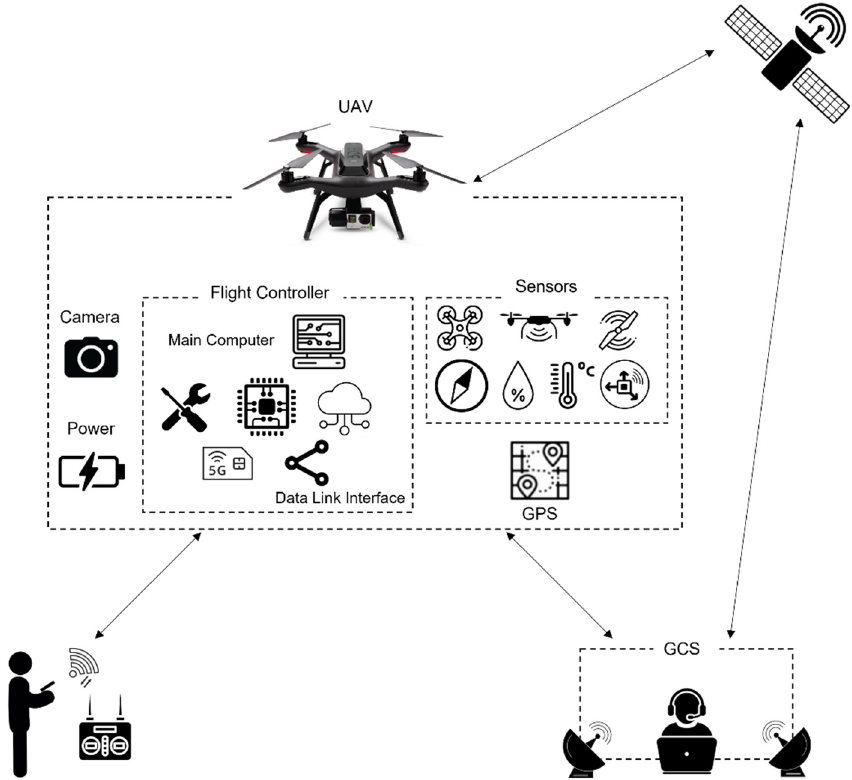
Figure 1. High-level architecture of a UAV.